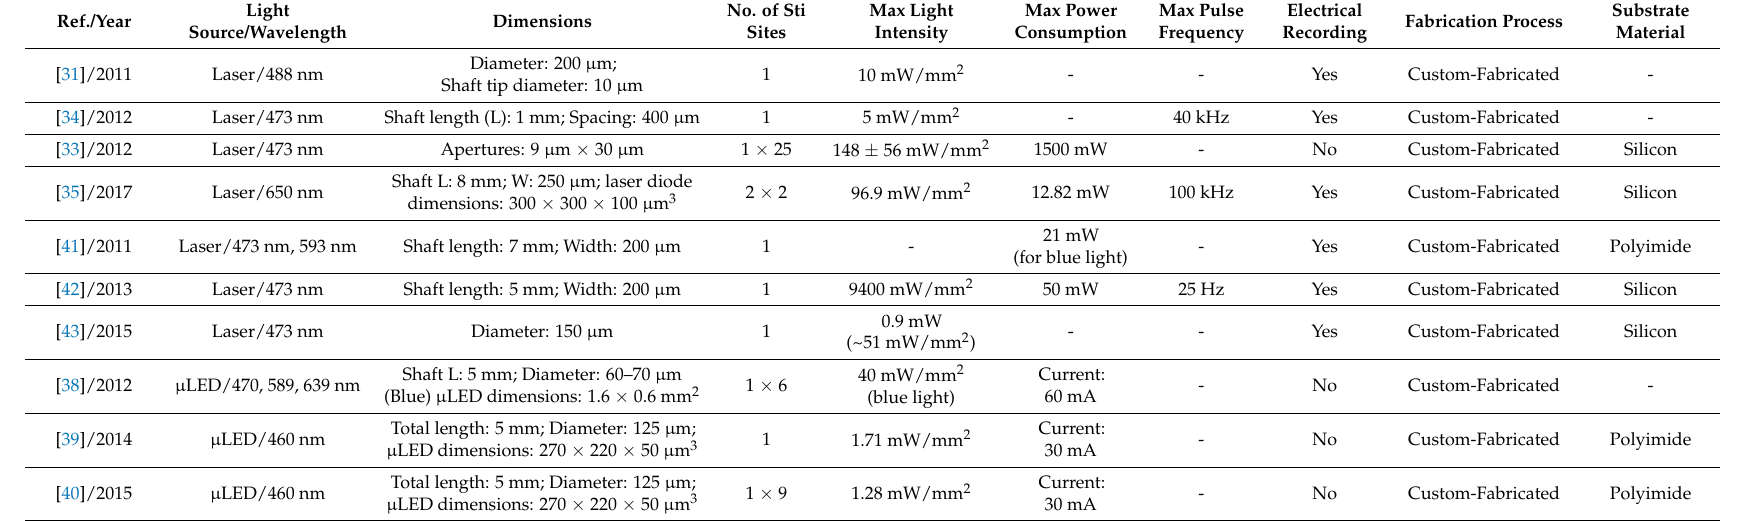
Table 1. Performance summary of recently published wave-guiding structure based optogenetic